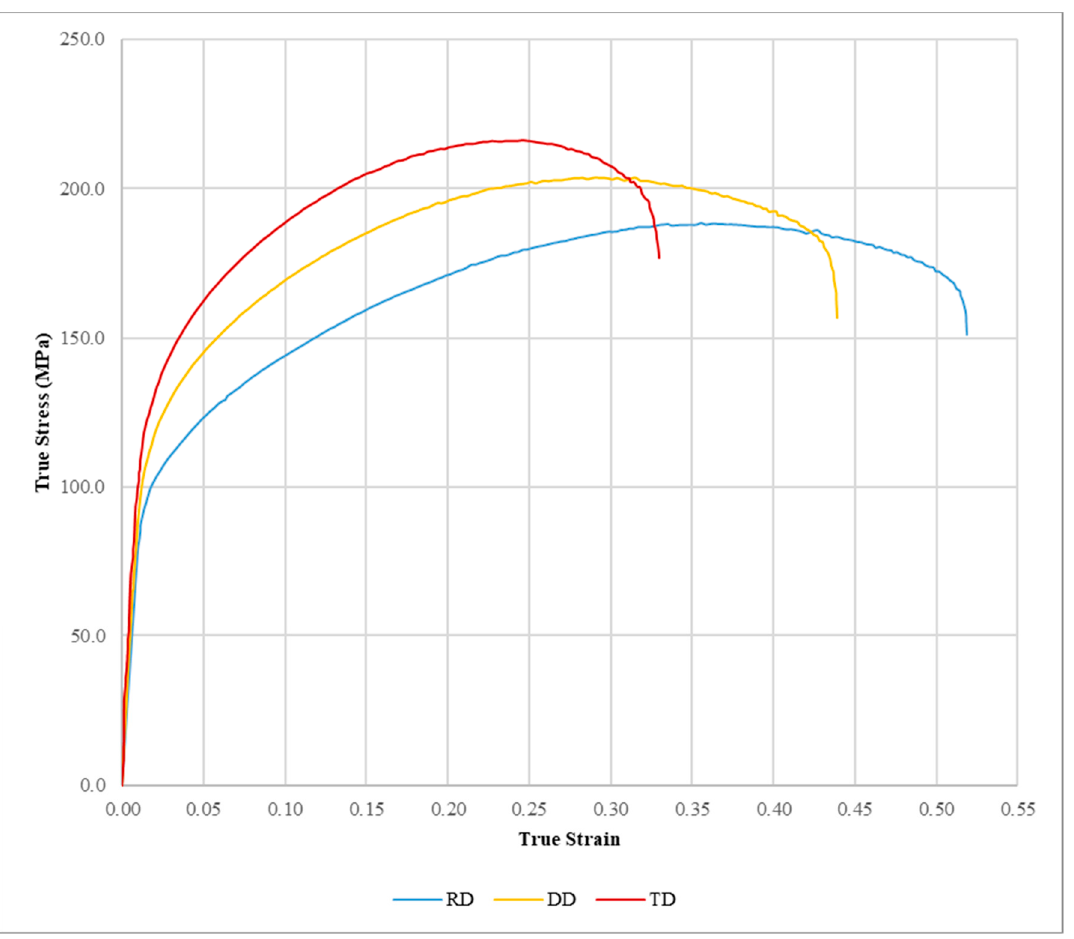
Figure 1. Experimental true stress-strain tensile curves for RD, DD and TD according to the data published in [1].